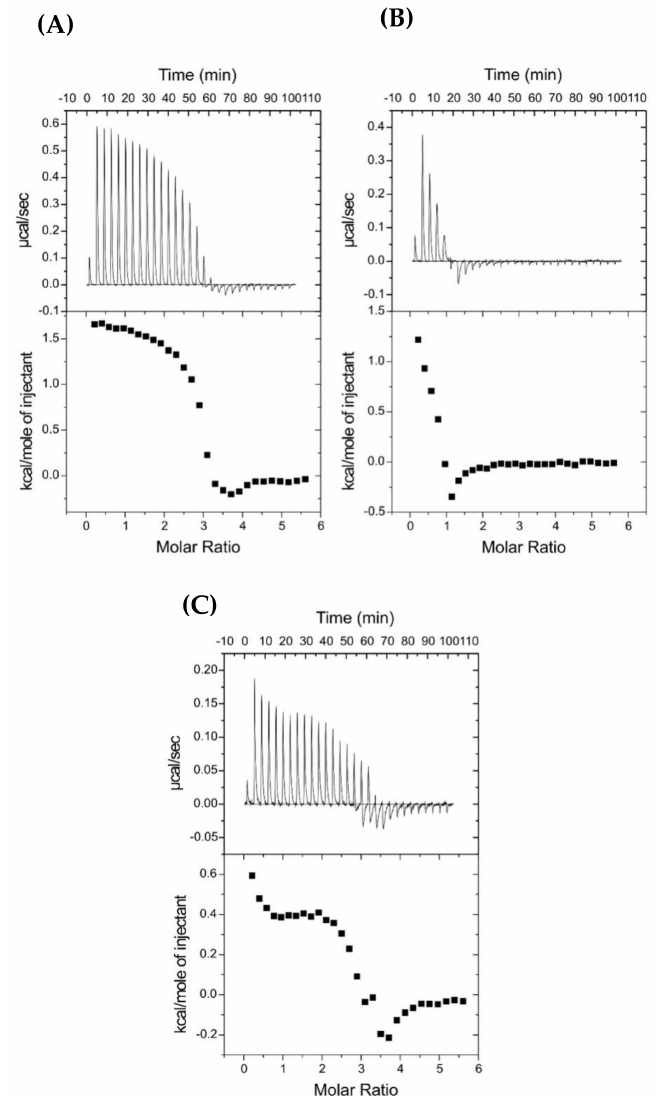
Figure 5. Isothermal calorimetric titration patterns obtained for titration of 0.05 mM ( A ) C5-DK5, represent the heat of reaction (measured by peak integration) as a function of the lipid/peptide molar